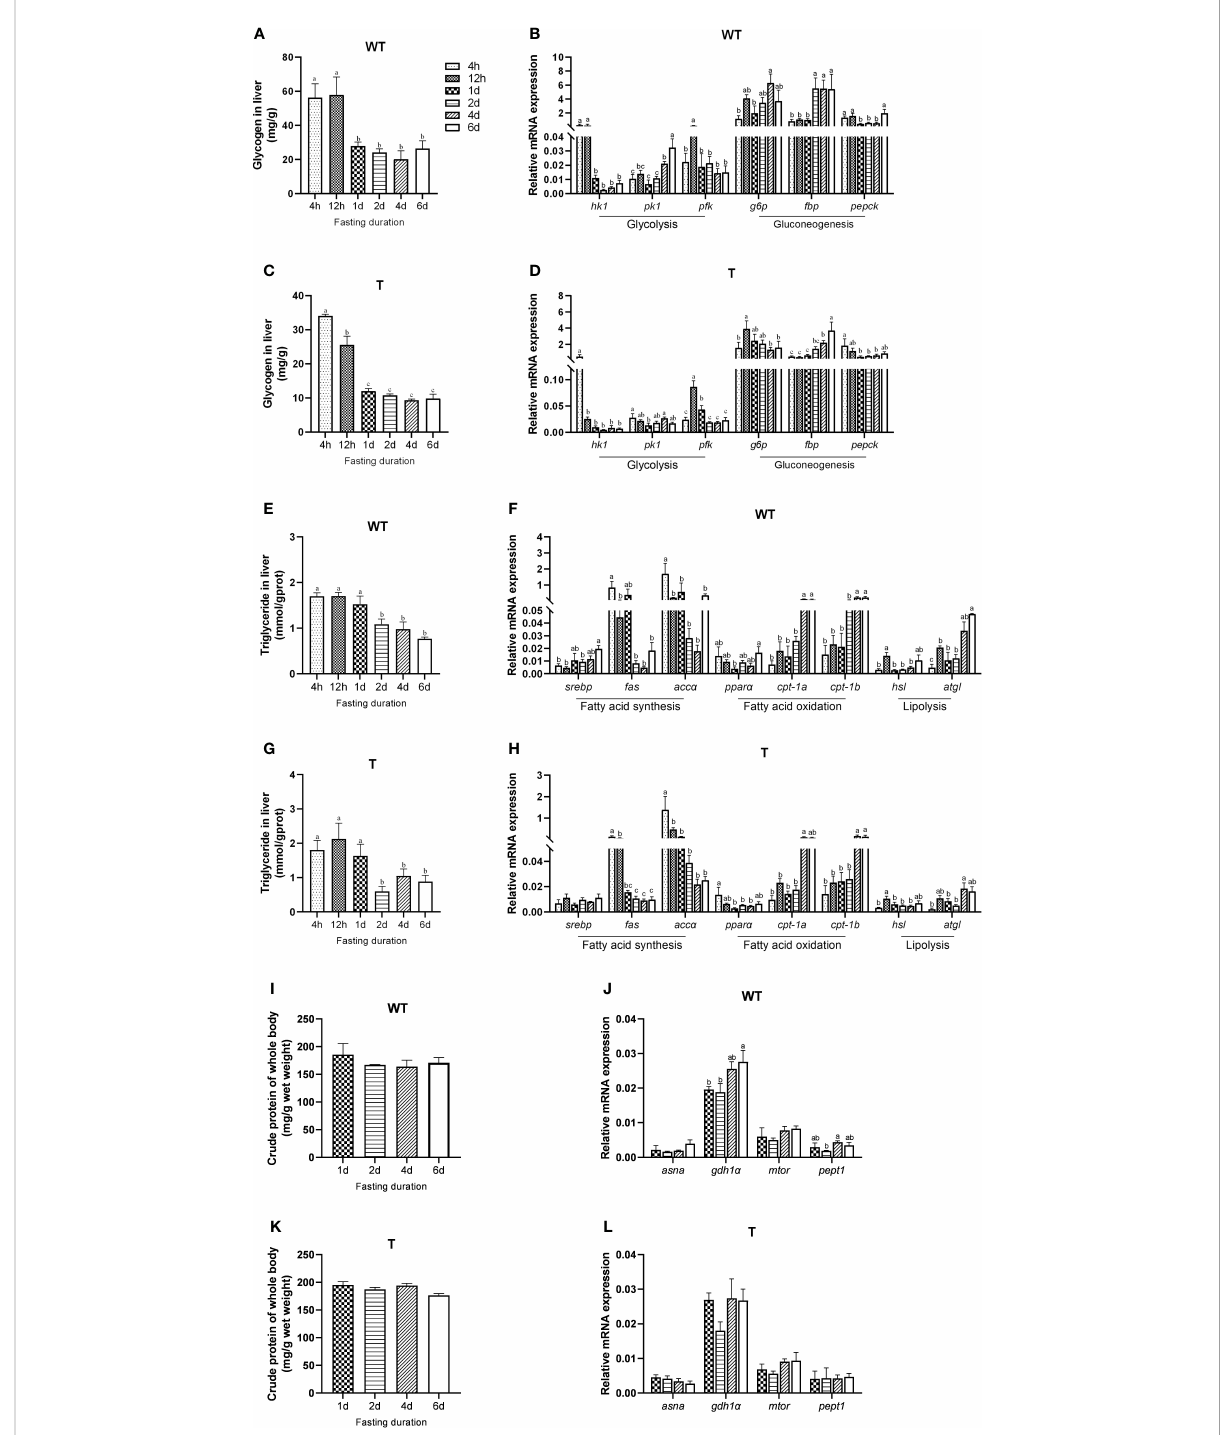
FIGURE 1 Mobilization of different energy sources during fasting of wild-type (WT) and GH transgenic (T) common carp (n = 4). (A, C) Hepatic glycogen content during fasting in WT and T common carp. (B, D) Hepatic expression level of genes involved in glycolysis and gluconeogenesis during fasting in WT and T common carp. (E, G) Hepatic triglyceride content during fasting in WT and T common carp. (F, H) Hepatic expression level of genes involved in lipogenesis and lipid catabolism during fasting in WT and T common carp. (I, K) Protein content of whole body during fasting in WT and T common carp. (J, L) Hepatic expression level of genes involved in protein catabolism during fasting in WT and T common carp. Statistical signi fi cance was determined via one-way analysis of variance. Different letters show signi fi cant differences among groups ( P <